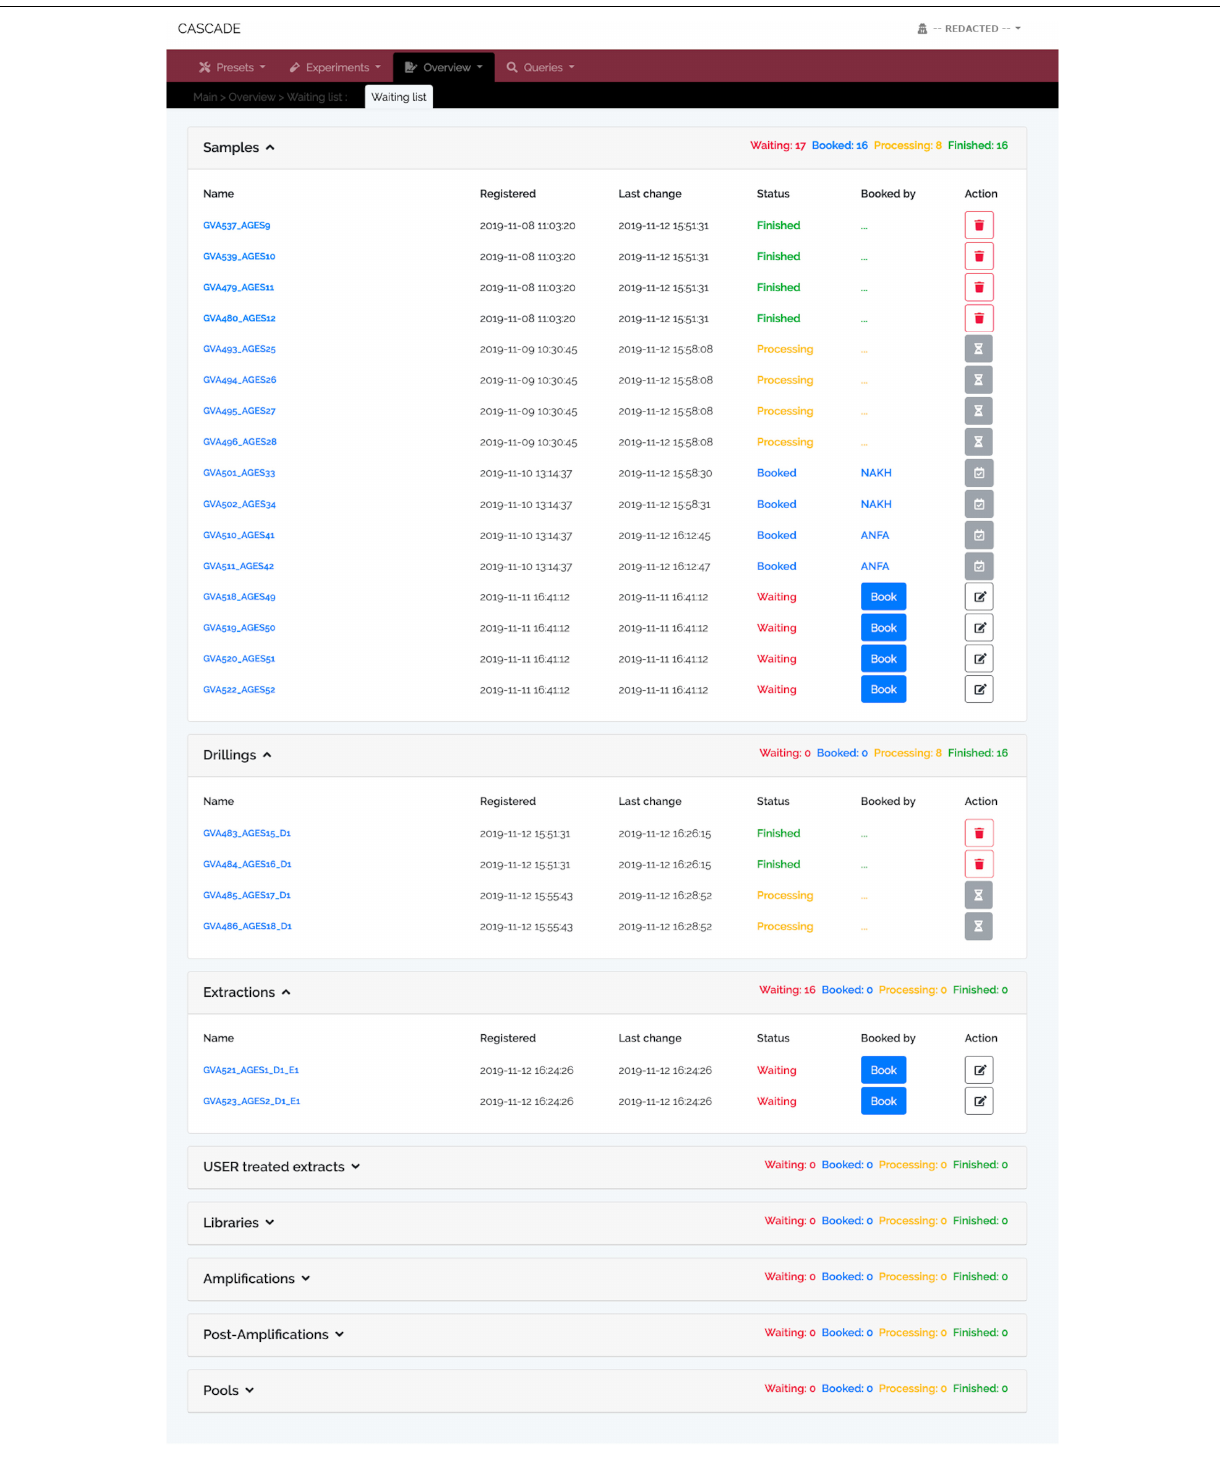
FIGURE 2 | Waiting list showing specimens at different processing stages. Registered samples (“ Samples ,” top), “ Drillings ” (middle), and “ Extractions ” (bottom). No records are available for the other experimental data types at this moment, and, hence, none are displayed. The “ Samples ” panel shows four samples each either “ Waiting ” to be processed, “ Booked ” for processing (by two different users “ NAKH ” and “ ANFA ”), currently undergoing “ Processing ,” or already “ Finished .” “ Finished ” entries show the delete trash button on the right allowing the user to remove them from the list and avoid clutter. Deletion does not happen automatically; it thus provides users with feedback of what has been done. Waiting entries have an edit button instead, which leads to a menu allowing all users to attach notes to the entry, e.g., special experimental conditions must be applied, location of the material, etc.